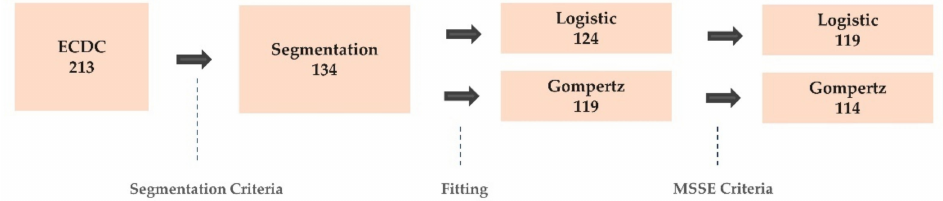
Figure 3. Differences in the number of countries across segmentation, growth curve models, and MSSE criteria. For the segmented logistic model, 124 countries were fitted, and for the segmented Gompertz model, 119 countries were fitted. To check (validate) the goodness of fit of the above 2 models, we employed MSSE (mean squared scaled error) criteria. For each of the two models, 5 countries showed high MSSE, and therefore those 5 countries were excluded in the subsequent analysis (Aruba, Equatorial Guinea, Krygyzstan, Rwanda, and Thailand for the segmented logistic model, and China, Equatorial Guinea, Kyrgyzstan, Rwanda, and Zambia for the segmented Gompertz